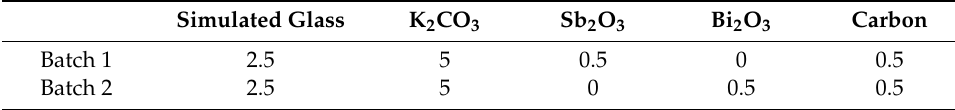
Table 2. The amounts of the compounds in batch heat treatment (unit: